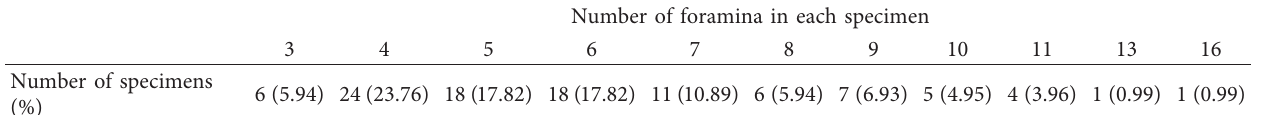
Table 6: Number of specimens ( n � 101) with foramina Number of foramina in each specimen